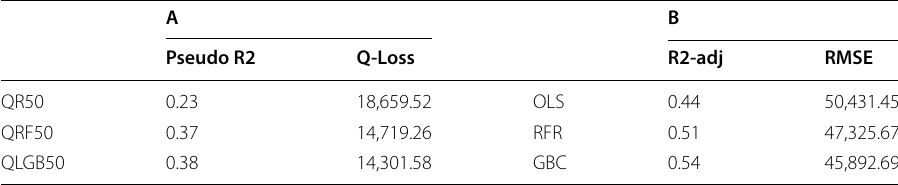
Table 6 Regression models results of pseudo R2, quantile loss, adjustes R2, and root mean squared error for Current Income variable